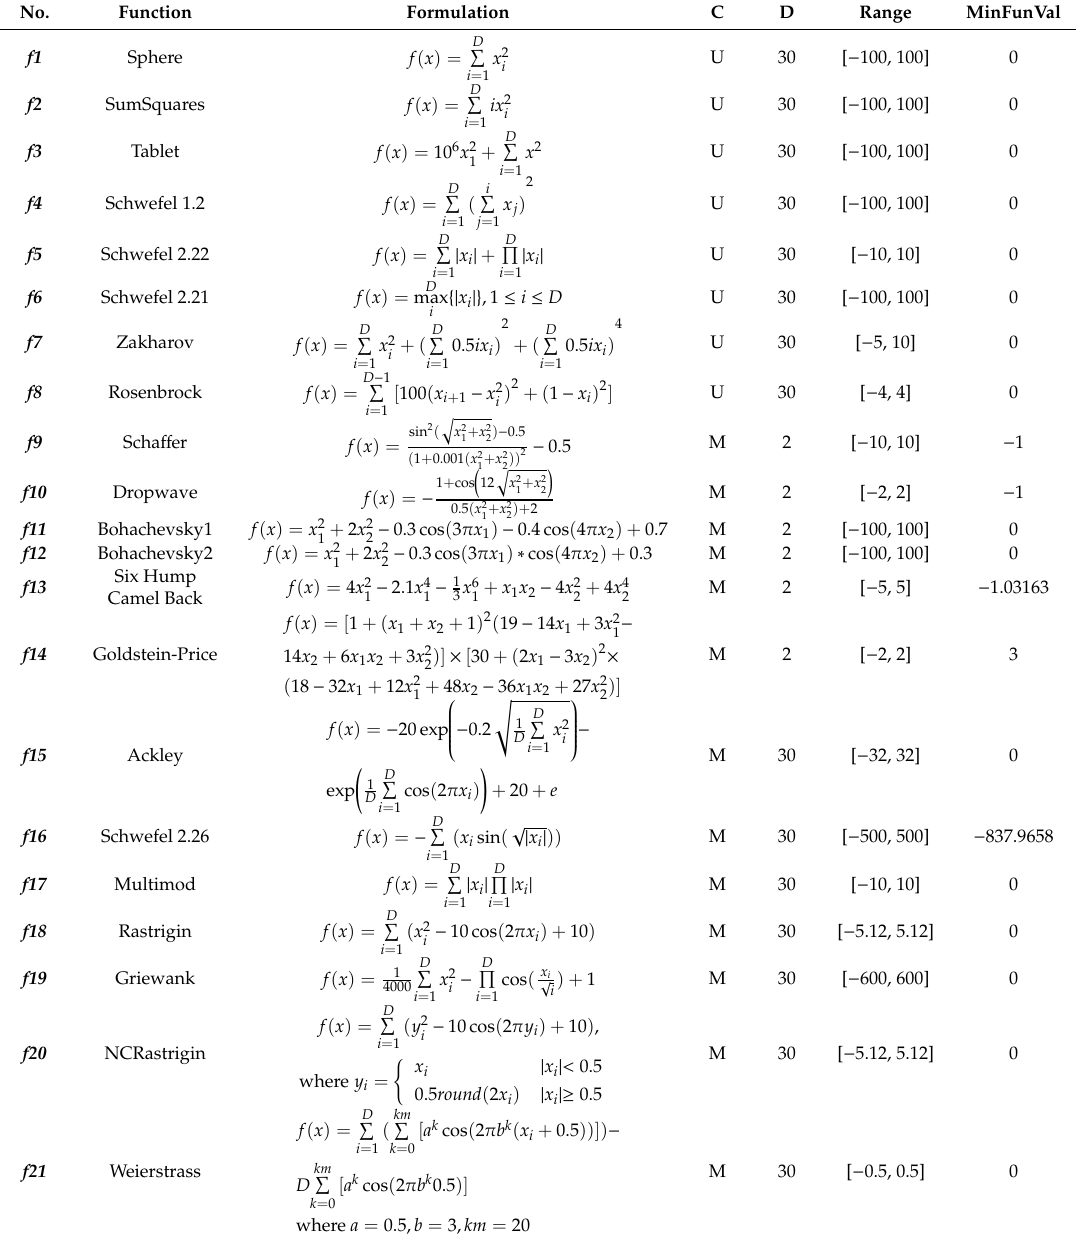
Table 1. The benchmark functions adopted in the